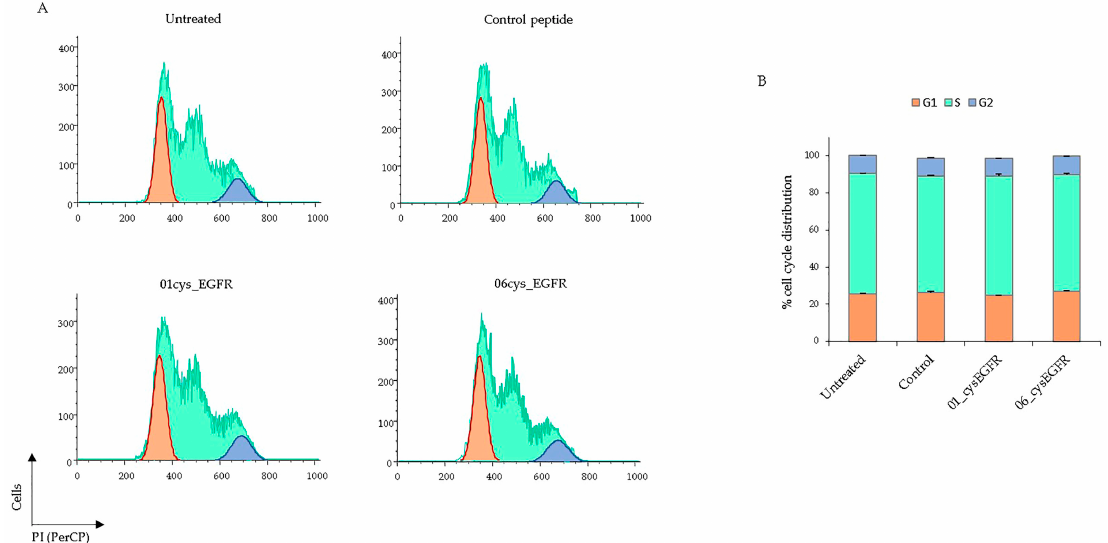
Figure 7. ( A ) The proportion of BT549 cells untreated or treated with 25 µM of control, 01cys_EGFR, and 06cys_EGFR peptides in G1, S, and G2 phases were determined by fl ow cytometry and and 06cys_EGFR peptides in G1, S, and G2 phases were determined by flow cytometry and quantified quanti fi ed by Flow Jo software using Watson Pragmatic method. ( B ) Histograms showed the by Flow Jo software using Watson Pragmatic method. ( B ) Histograms showed the percentage of cell percentage of cell cycle phase distribution of PI-stained TNBC cells. Data are collected from two cycle phase distribution of PI-stained TNBC cells. Data are collected from two different experiments di ff erent experiments and presented as means ± SD. Paired t -test indicates no statistical signi fi cance and presented as means ± SD. Paired t -test indicates no statistical significance between peptide- between peptide-stimulated and unstimulated cells. stimulated and unstimulated